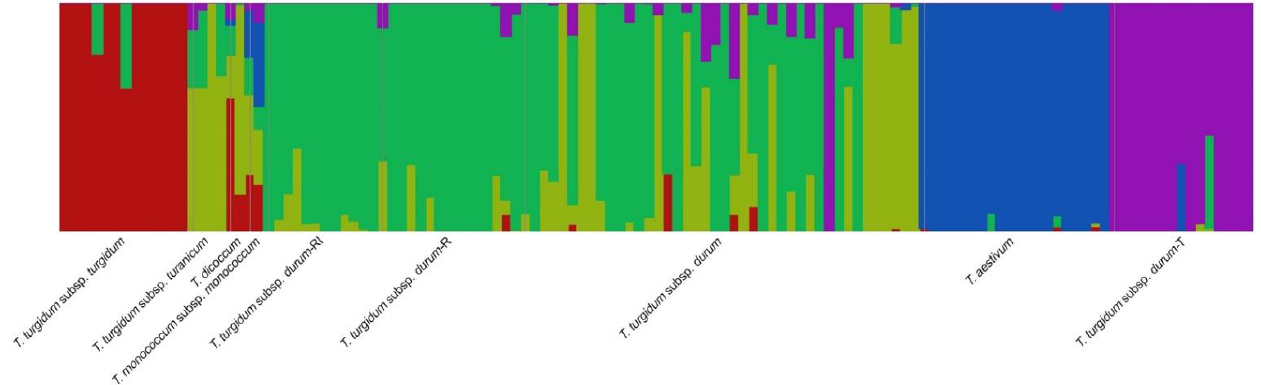
Figure 2. Population structure in the entire wheat dataset (126) as analyzed in the 90k SNP array. The optimum pool number was recorded at K = 5 by fastStructure. Each sample is represented by a vertical bar. The color proportion for each bar represents the posterior probability of assignment of each variety to one of the five groups of genetic similarity and ranges from 0 to 100% of the assignment probability range (Table S4).